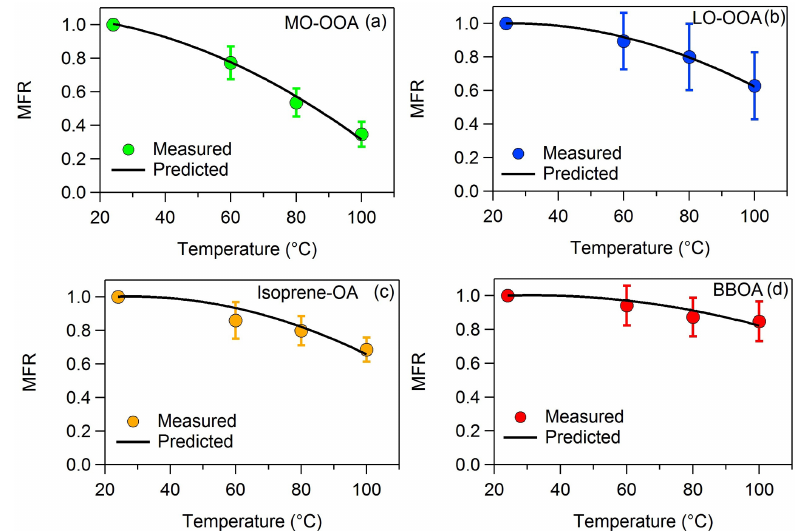
Figure 2. MFRs of the loss-corrected (a) MO-OOA, (b) LO-OOA, (c) isoprene-OA and (d) BBOA. The circles represent the measurements with the 1 standard deviation of the mean. The black line corresponds to the best-predicted MFR using the algorithm of Karnezi et al.